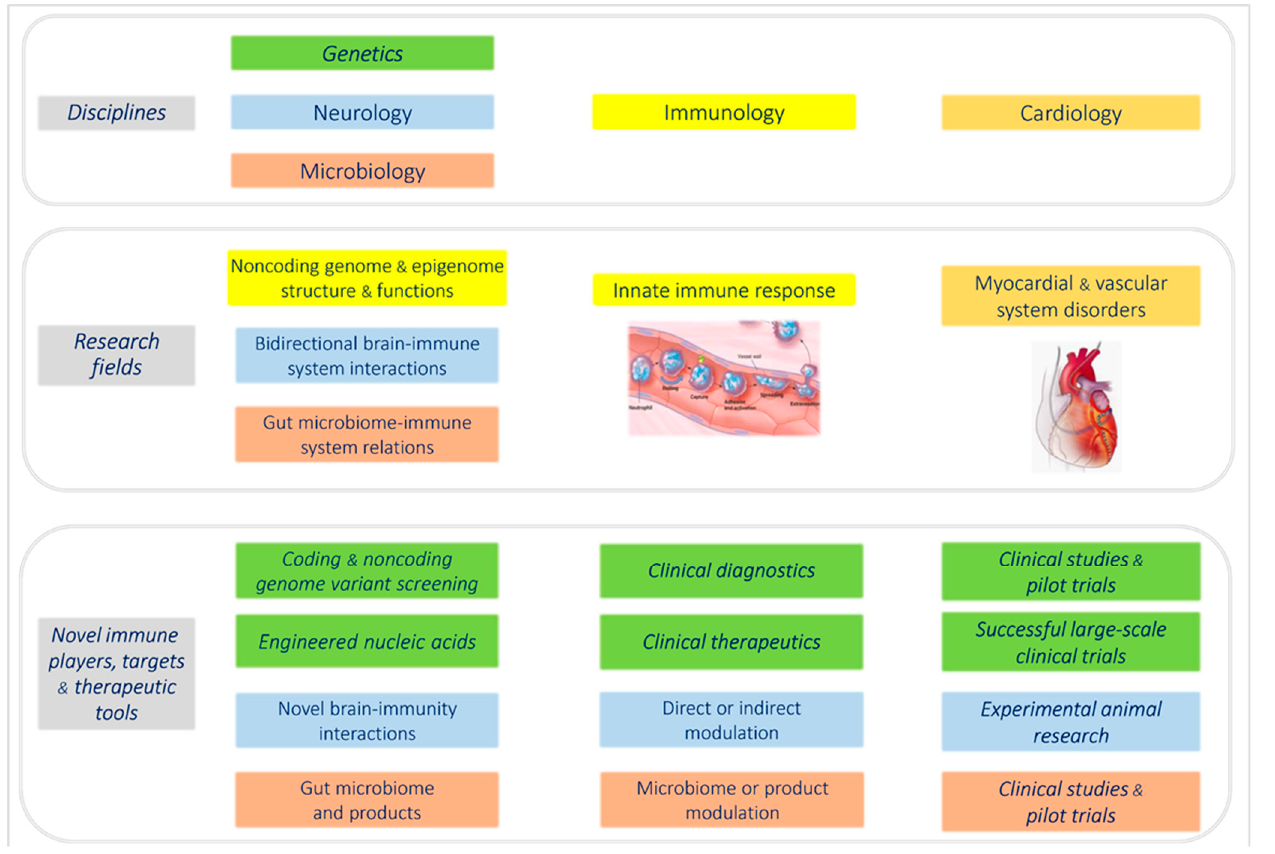
Figure 1. New research areas for cardiovascular disease immunity. Several rapidly expanding re-